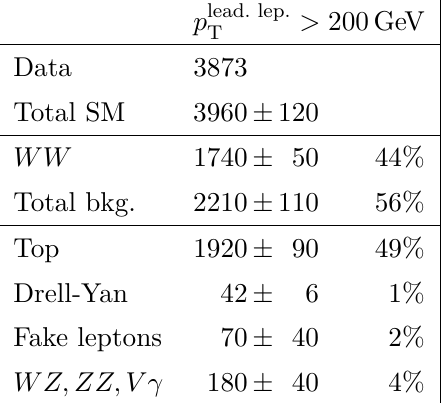
Table 9 . Selected WW candidate events, together with the signal prediction and the background estimates for p lead. lep.